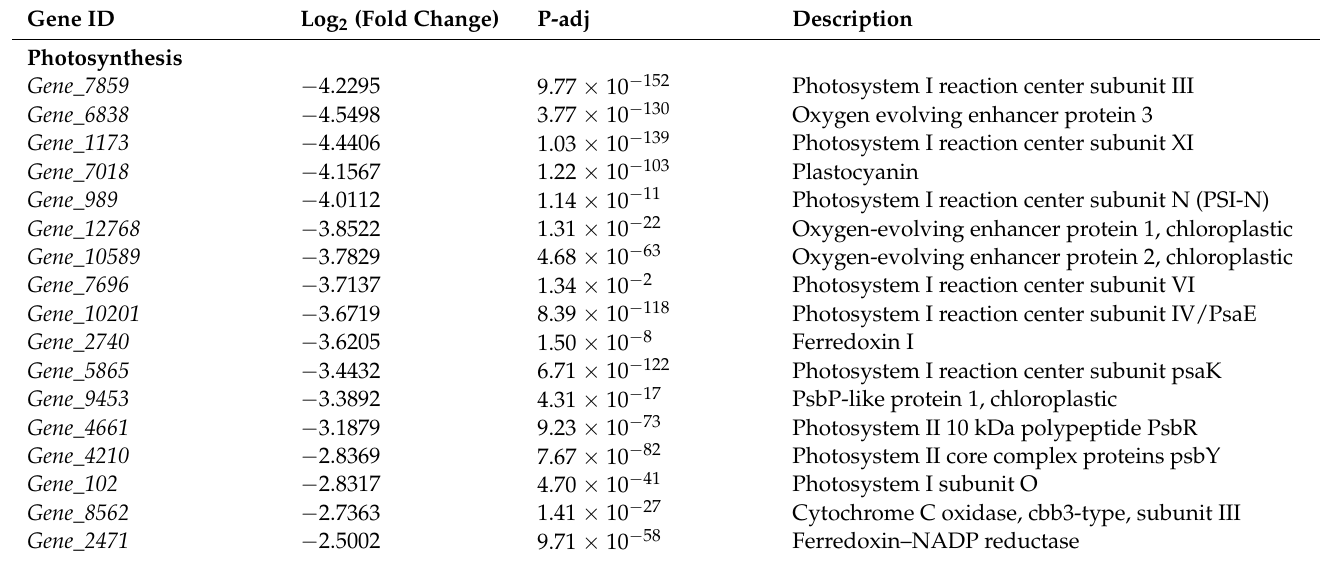
Table 2. Differentially expressed genes in photosynthetic process in the RNA-seq